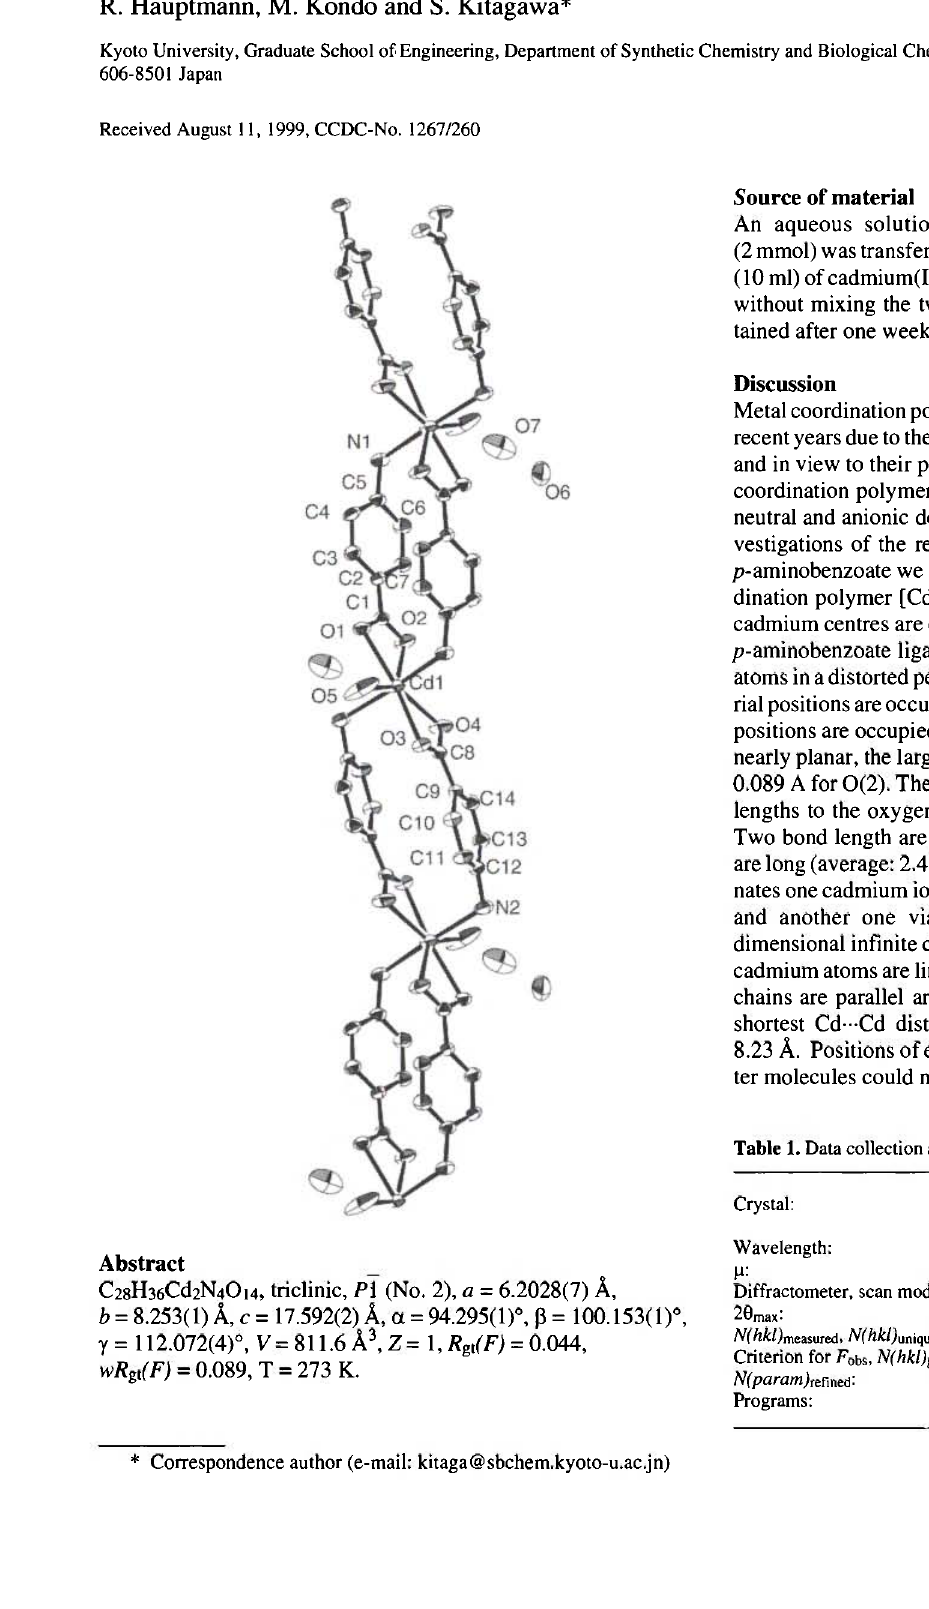
Table 1. Data collection and handling.